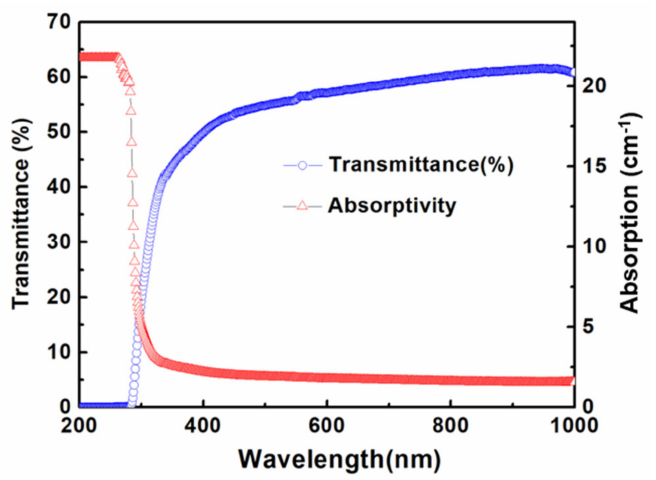
Figure 5. The measured transmission and absorption spectra of the CaNb 2 O 6 crystal at room